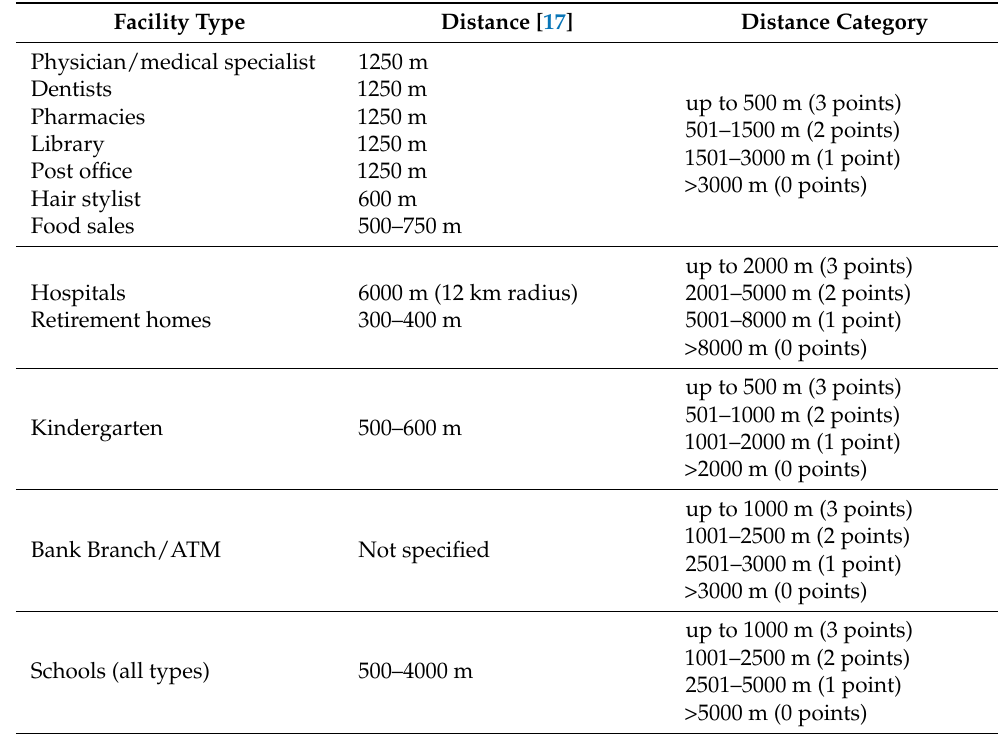
Table 1. Facility types and used distance categories. Source: own